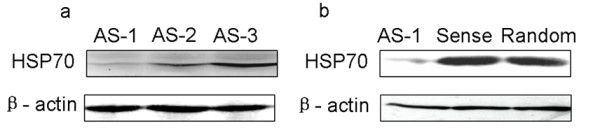
Knock-down effect of HSP70 antisense oligos. Hep-2 cells were transfected with HSP70 antisense oligos (AS) or control oligos (sense oligos and random oligos) as described under materials and methods. After incubation for 48 h, cells were harvested, lysed. Western-blotted (WB) with the corresponding antibodies was carried out to show the knock-down effect of AS. AS-1 has the best knock-down effect of all 3 oligos.